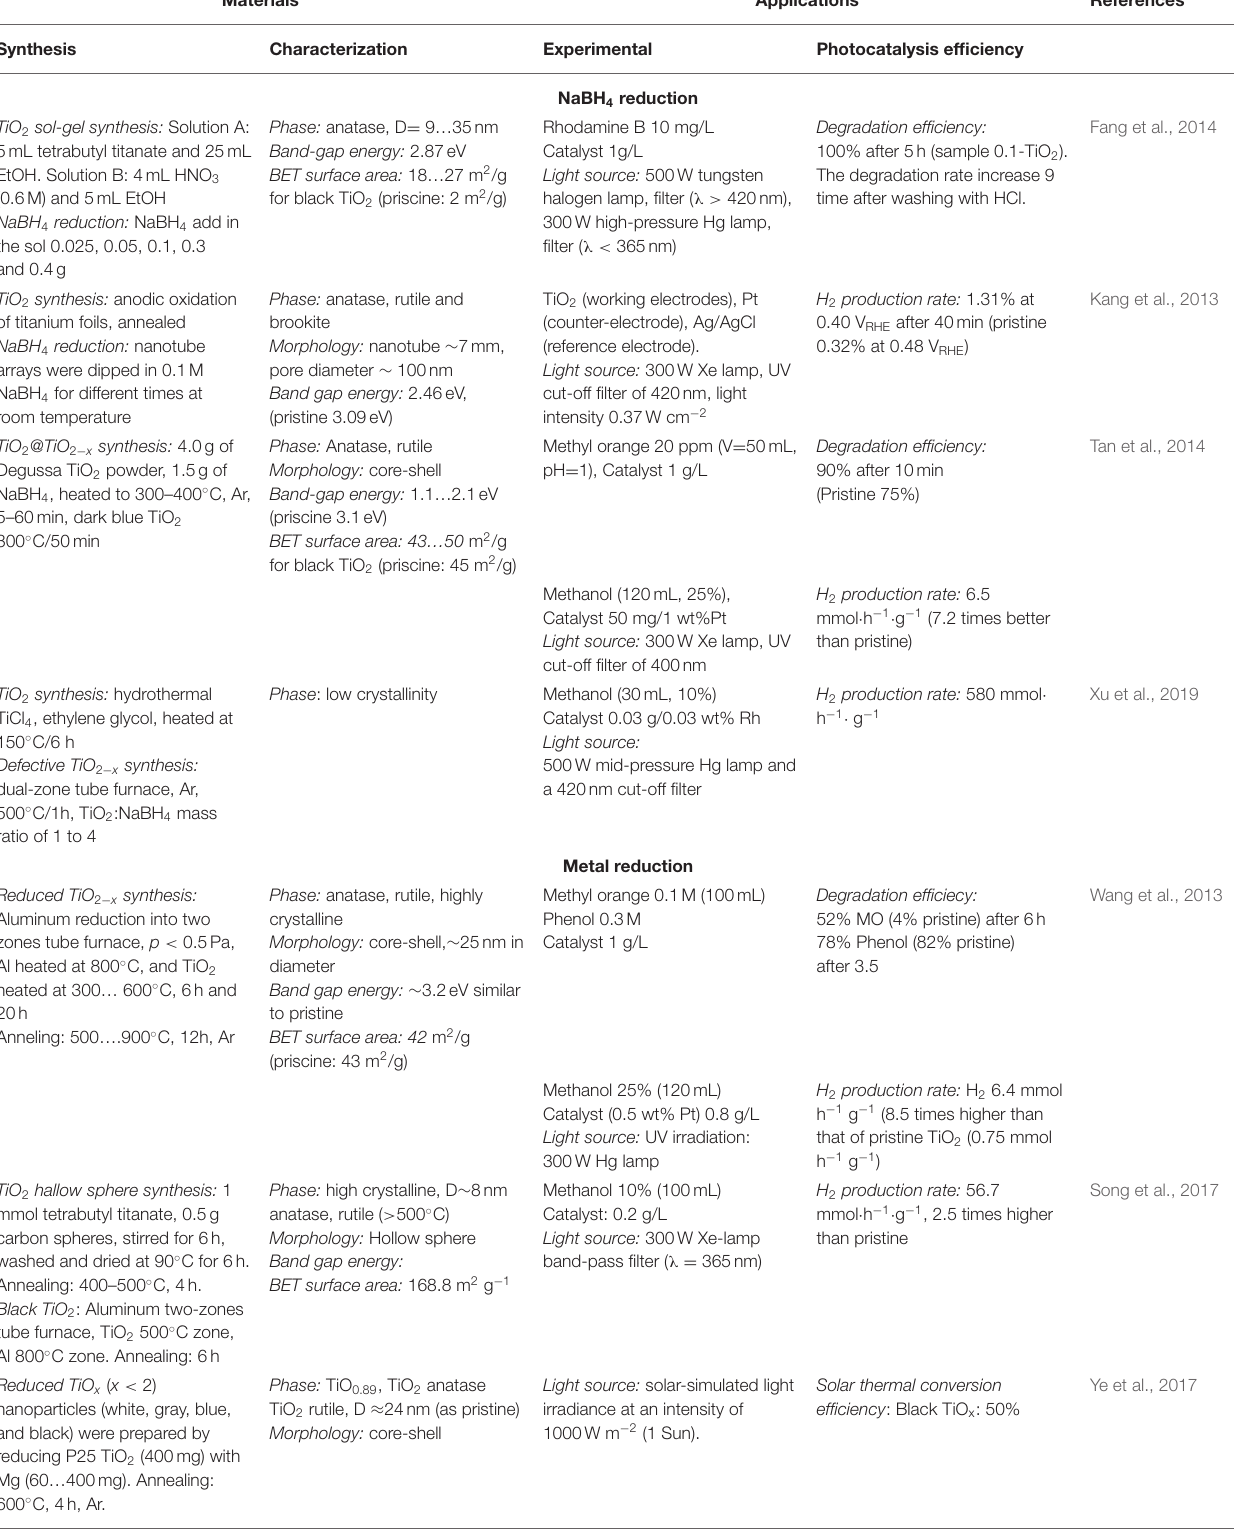
TABLE 1 | The chemical reduction synthesis methods, properties and photocatalytic applications of representative black TiO 2 materials.